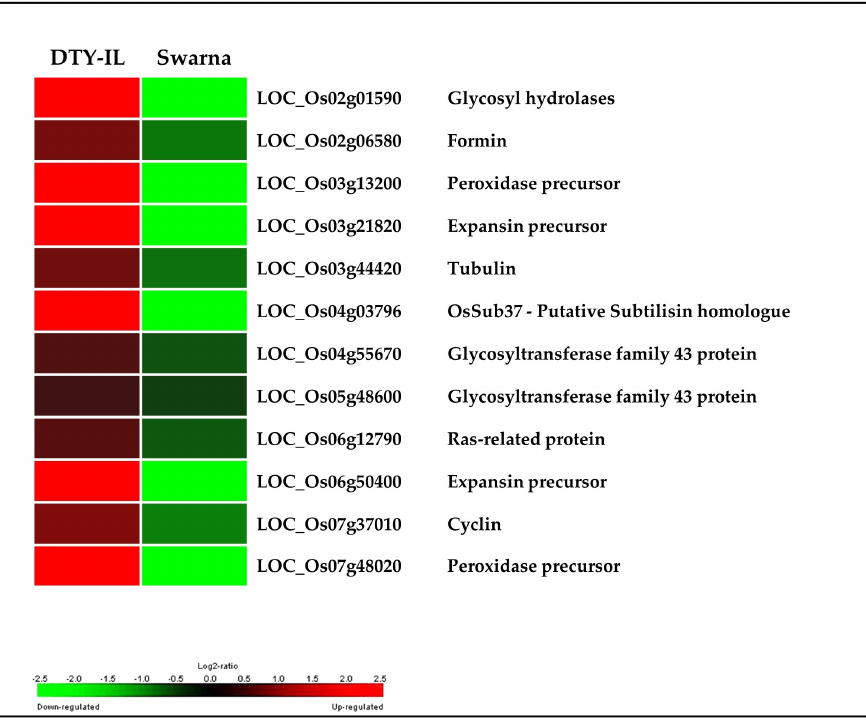
Figure 6. Cell wall organization and biogenesis during RDS in the flag-leaf tissue. Expression of cell wall organization or biogenesis related genes in drought-responsive modules between DTY-IL and Swarna are shown as log 2 fold change heat-maps.